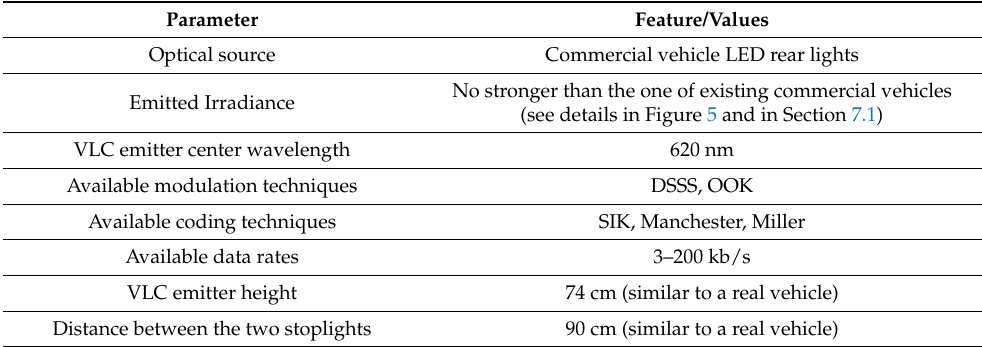
Figure 7. Hardware implementation of the V2V VLC system. Table 1. Summary of the VLC emitter parameters.